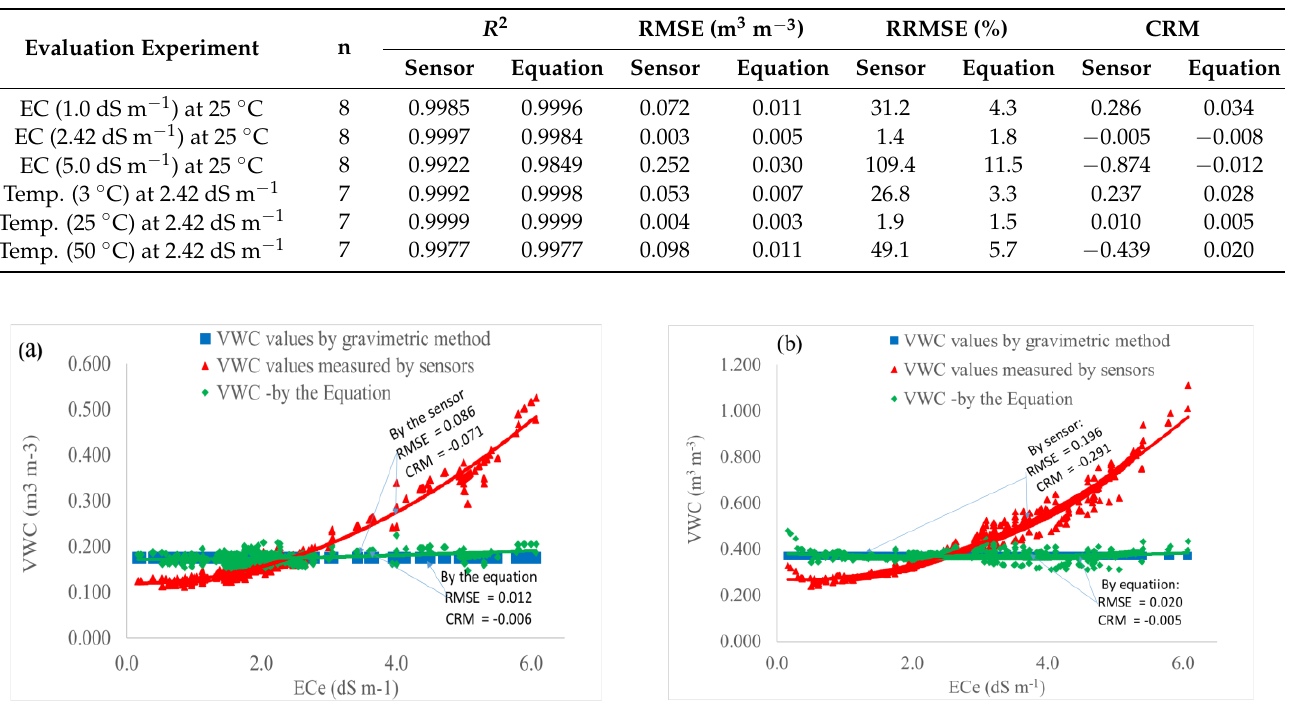
Figure 10. Comparison between VWC values measured by sensor, by gravimetric method, and by proposed L&O correction equation with a gradual increase in soil EC at 25 °C, tested at ( a ) soil moisture at field capacity and ( b ) soil moisture at saturated point.